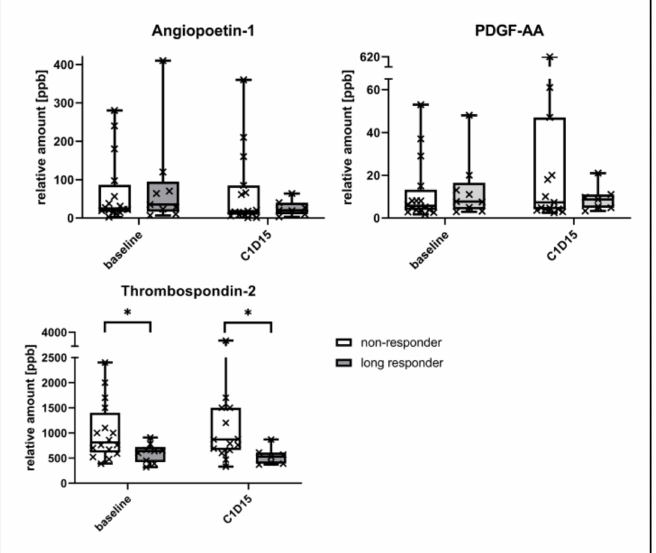
Figure 1. Comparison of angiogenesis-related blood proteins between long responders with early non-responders, measured by ELISA quantification. * p -value < 0.05; PDGF: Platelet-derived growth factor-AA; ppb: Parts per